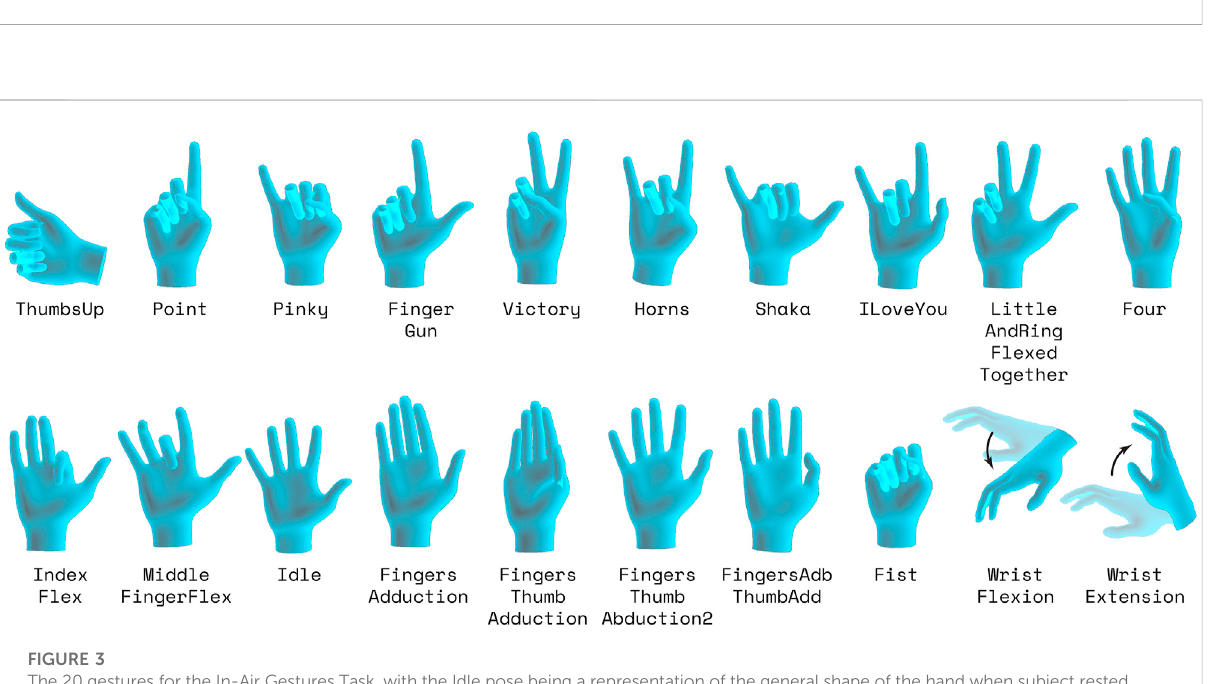
FIGURE 2 Thedescriptionofthestackingtask.Shownaretheobjectsusedforeachforeachofthetargetheightsduringthetask,aswellastheviewofthe user. The various target heights are described numerically.